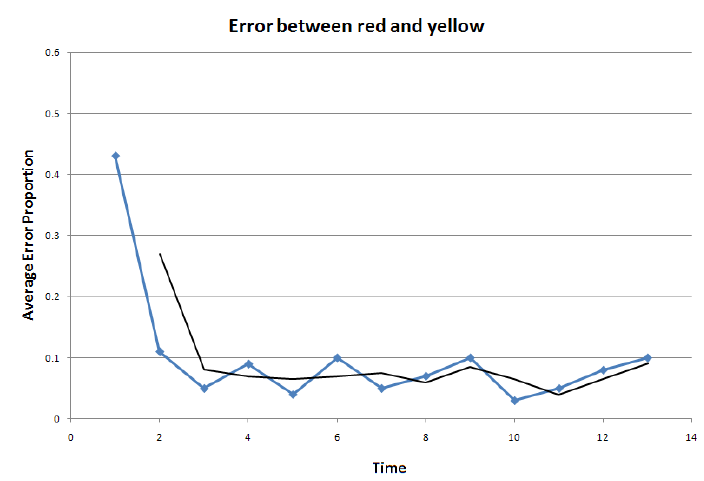
Figure 19. Error between the red and yellow